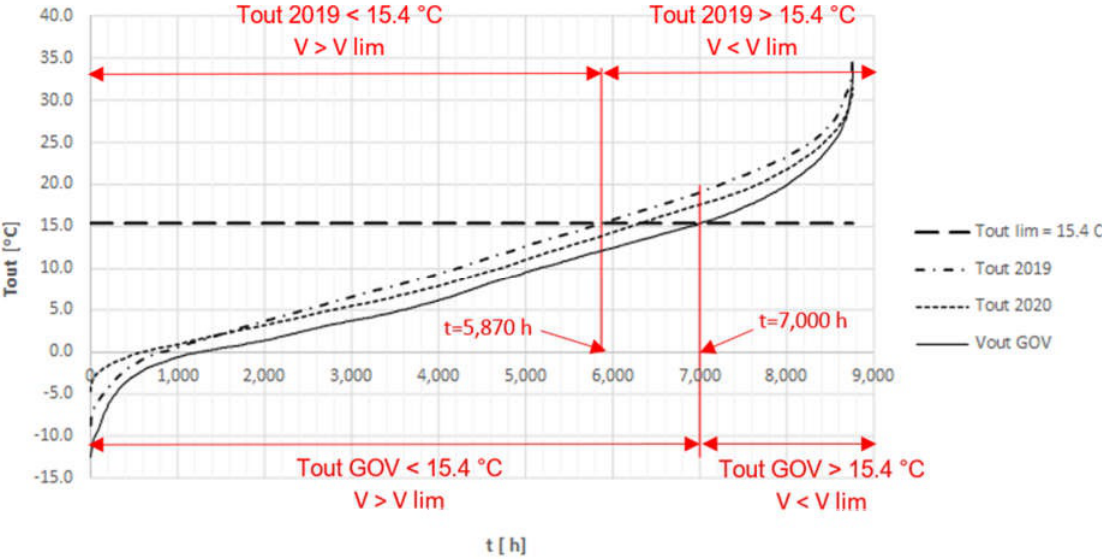
Figure 12. Line graph of measurements outdoor air temperature for Lodz based on the government database and meas- urements.